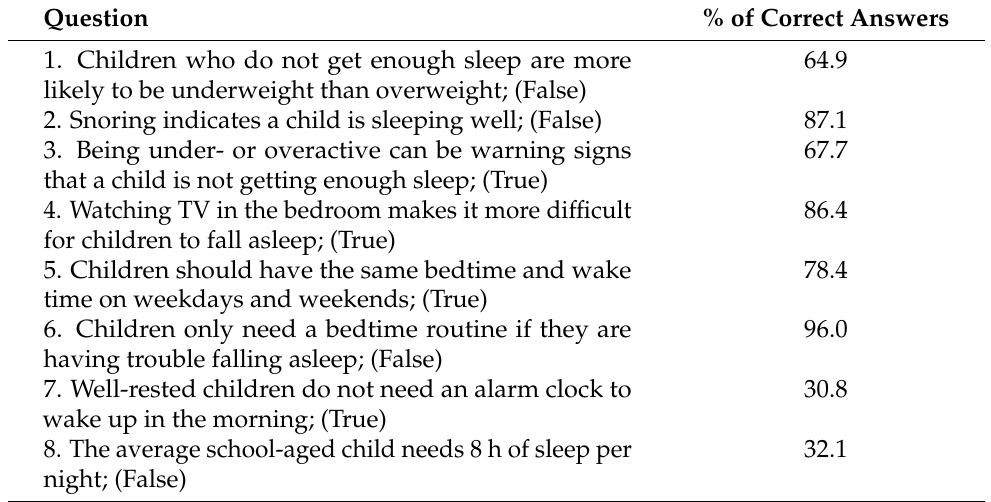
Table 4 Correct answers in brackets, “(True)” or “(False)”. Sleep Knowledge Questionnaire from Owens and Jones (2011). The mean score of correct answers was 5.43, SD = 1.38 with the highest possible score being